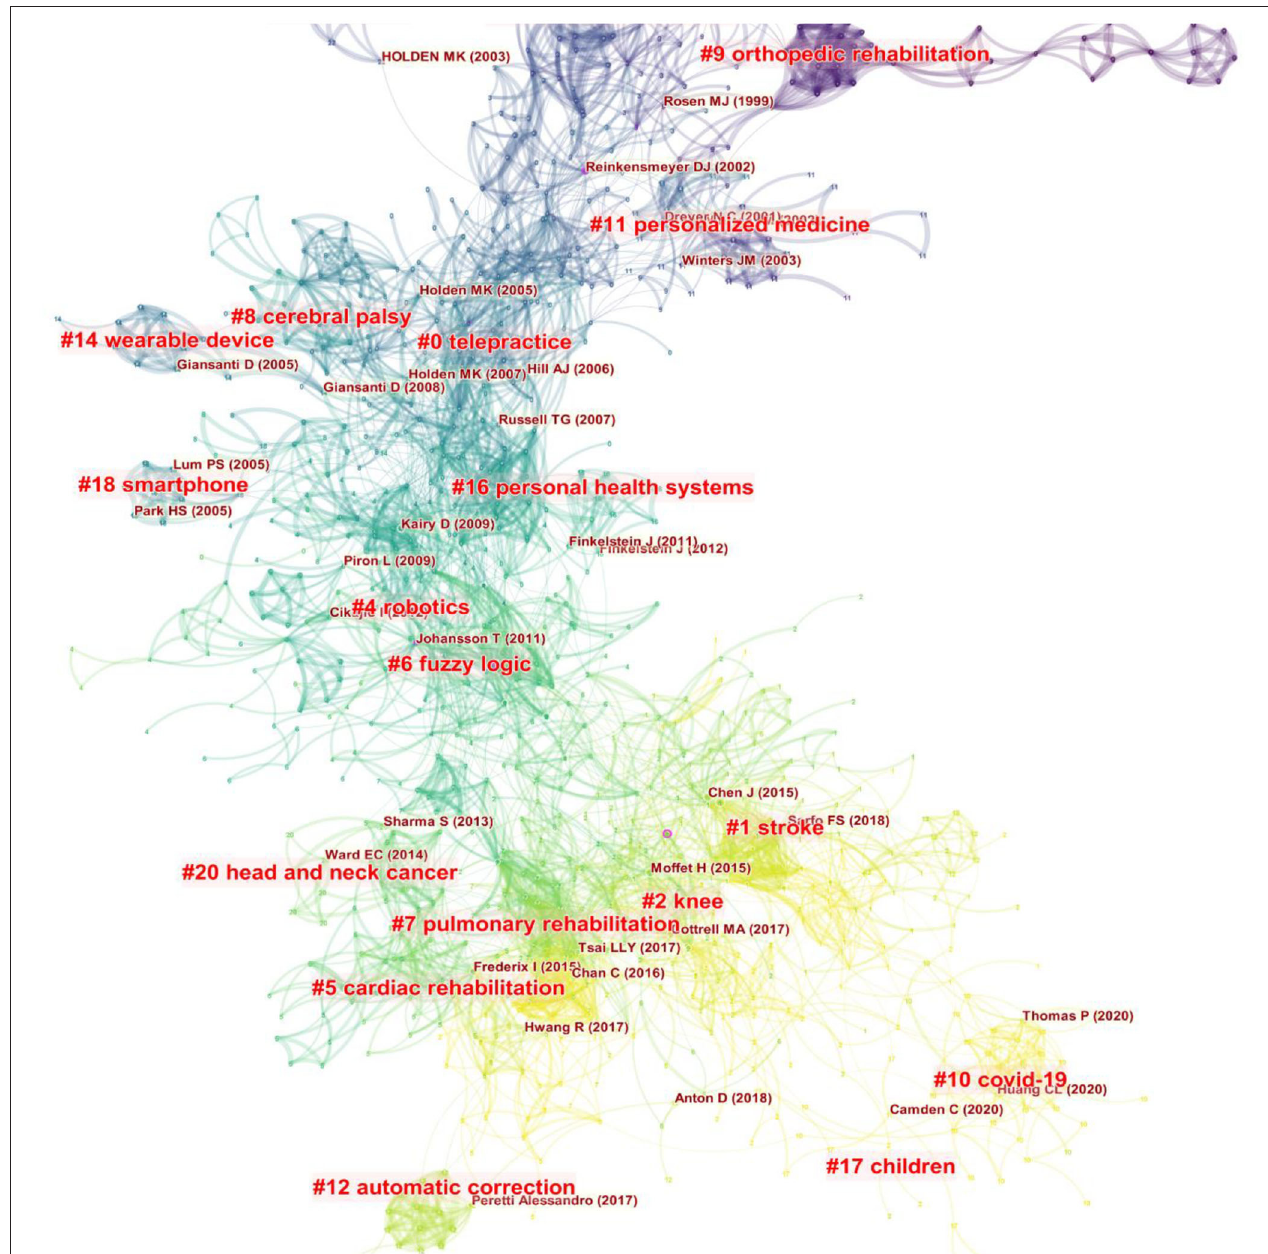
FIGURE 8 | The clustering map of cited references related to